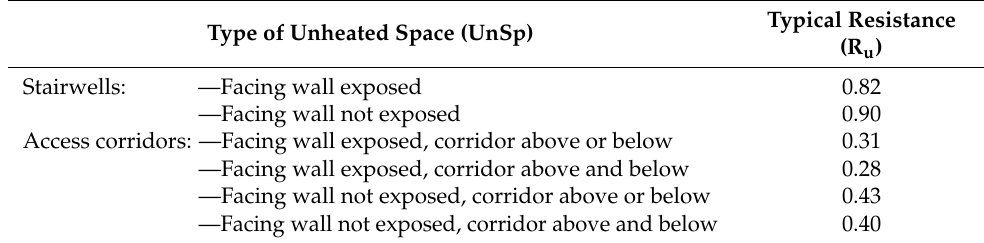
Table 5. Typical R u values for unheated stairwells and access corridors in flats (adapted from [11]).